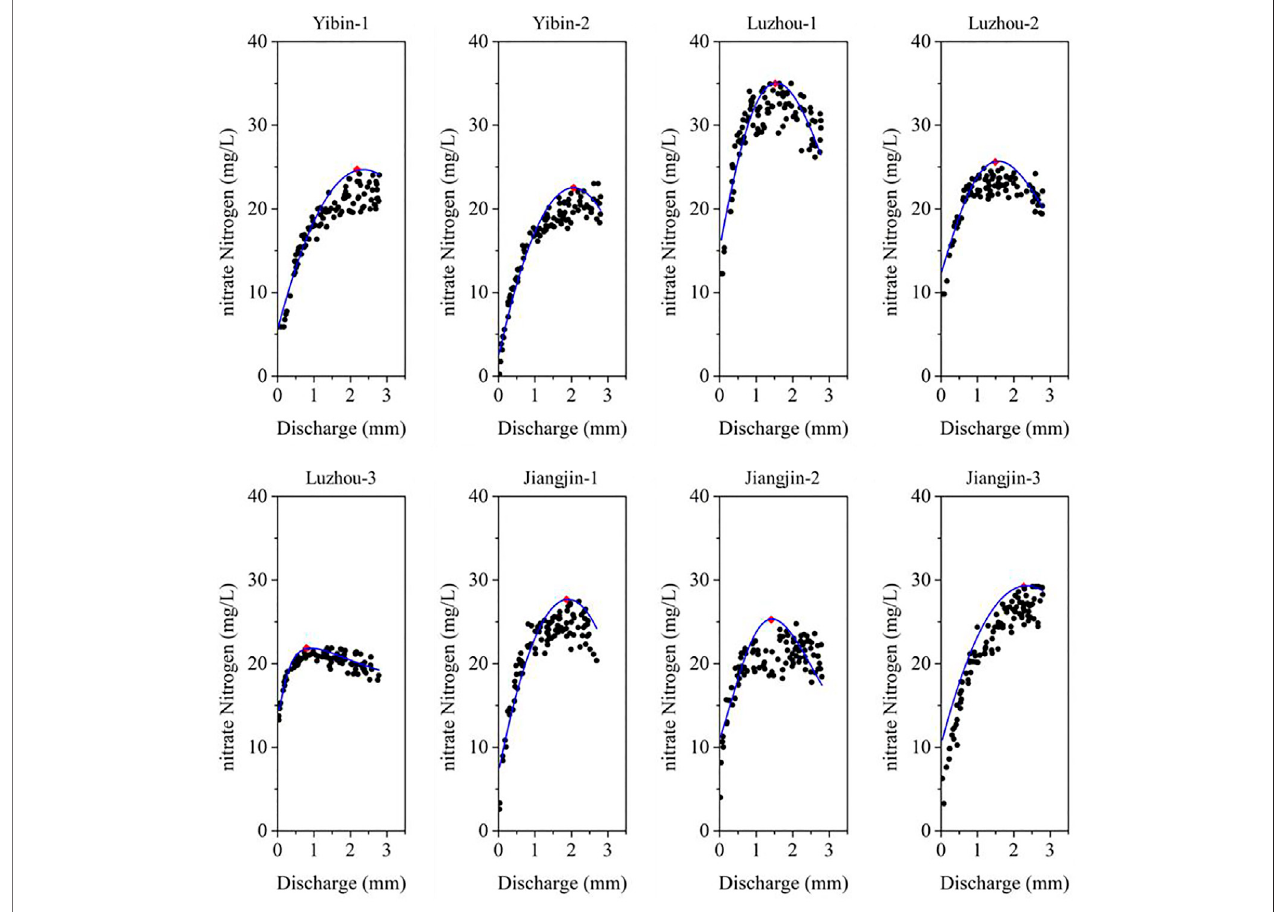
FIGURE 7 | Scatterplots of nitrate concentration versus discharge and turning points.